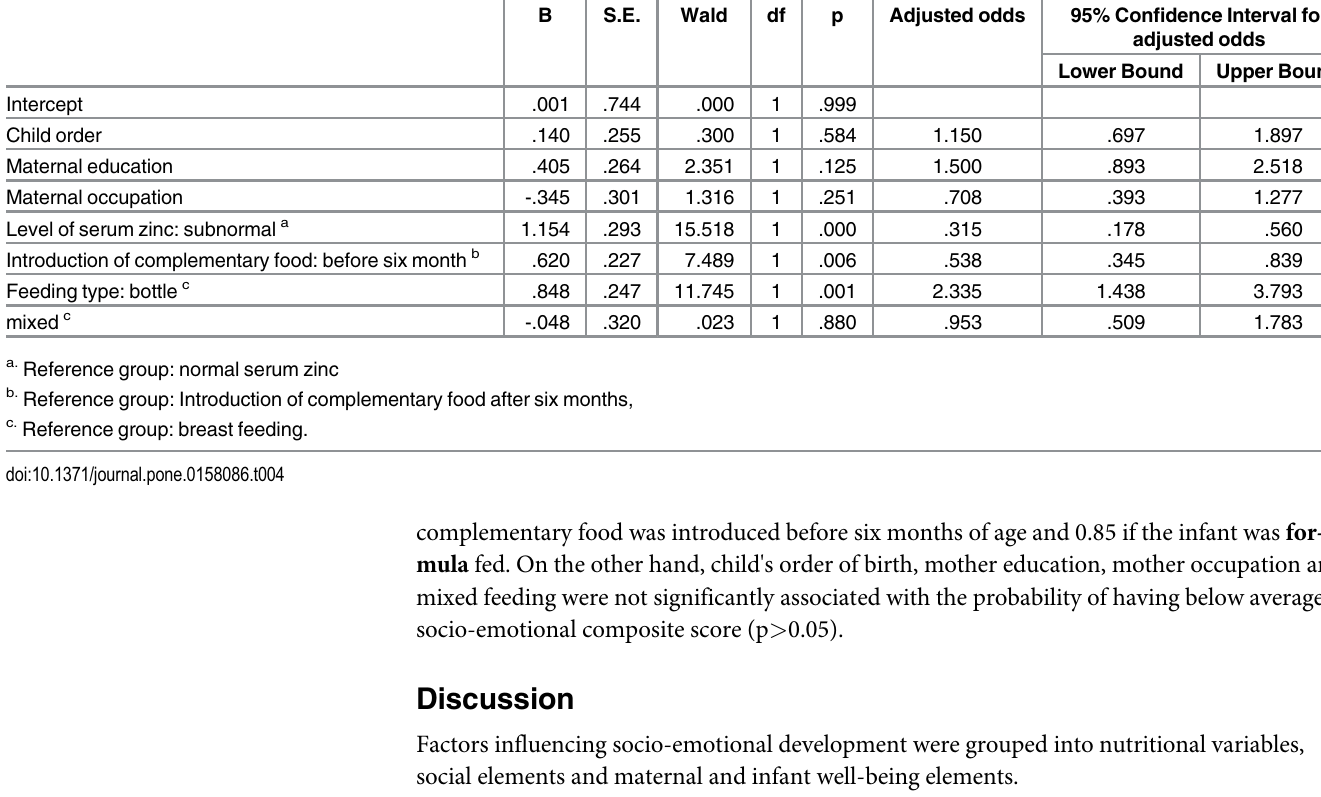
Table 4. Logistic regression of variables predicting below average socio-emotional composite